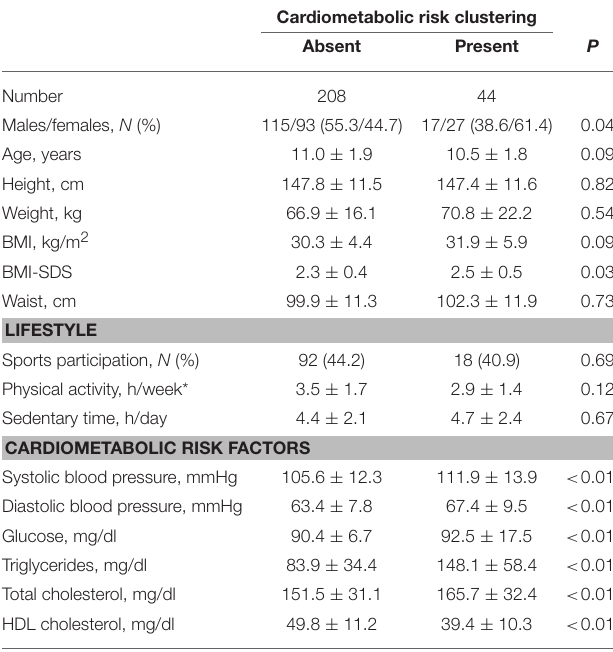
TABLE 2 | Anthropometric, lifestyle, and cardiometabolic features of the study population according to cardiometabolic risk clustering. Cardiometabolic risk clustering